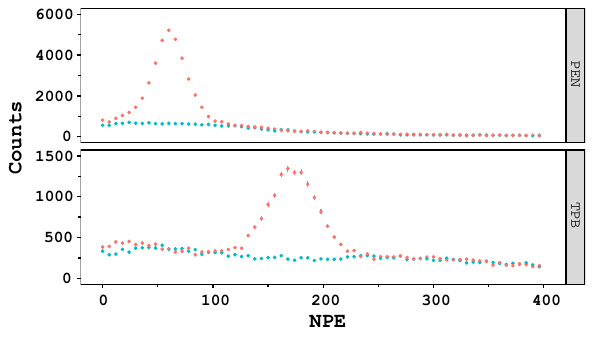
Fig. 6 Light yield of the chambers equipped with PEN and TPB (top panel) and their ratio (bottom panel) for two experiments runs